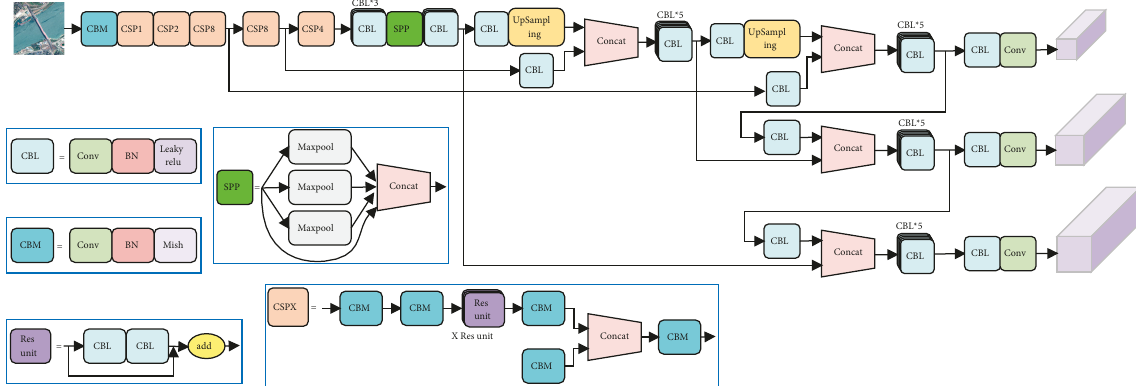
Figure 3: The architecture of YOLOv4